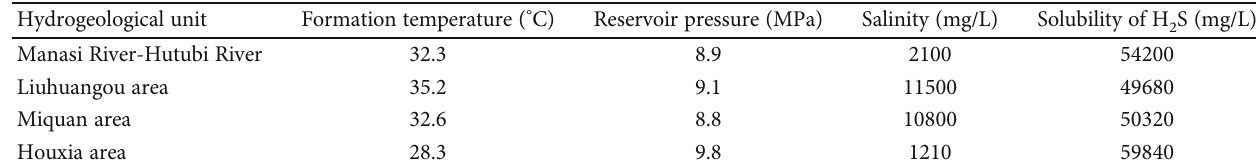
Table 3: Reservoir parameters of 1000m depth of coal measures and solubility of H Hydrogeological unit